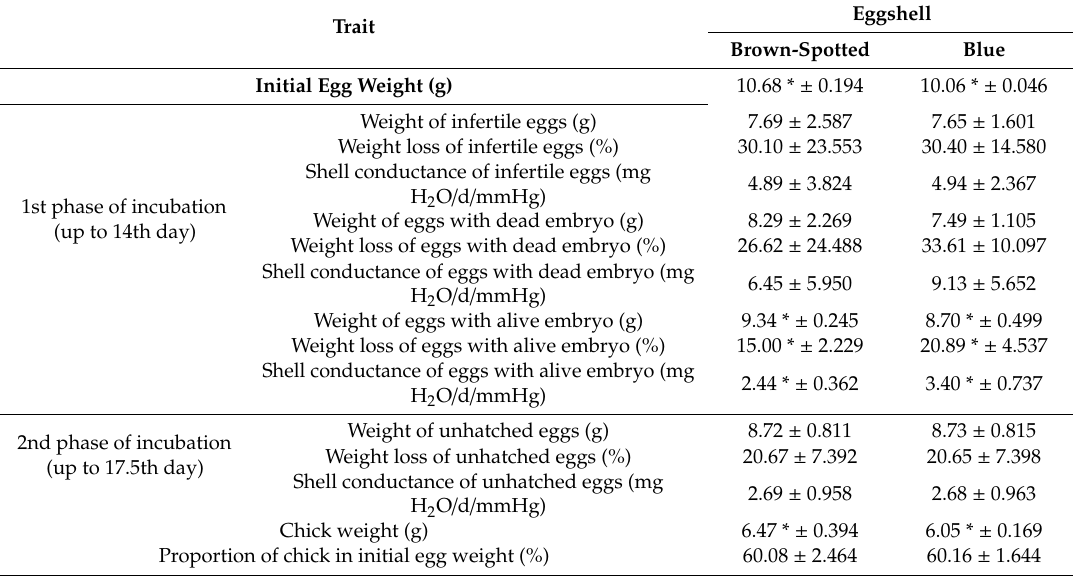
Table 4. Weight changes of incubated Japanese quail eggs depending on their shell colour (mean ± SD).